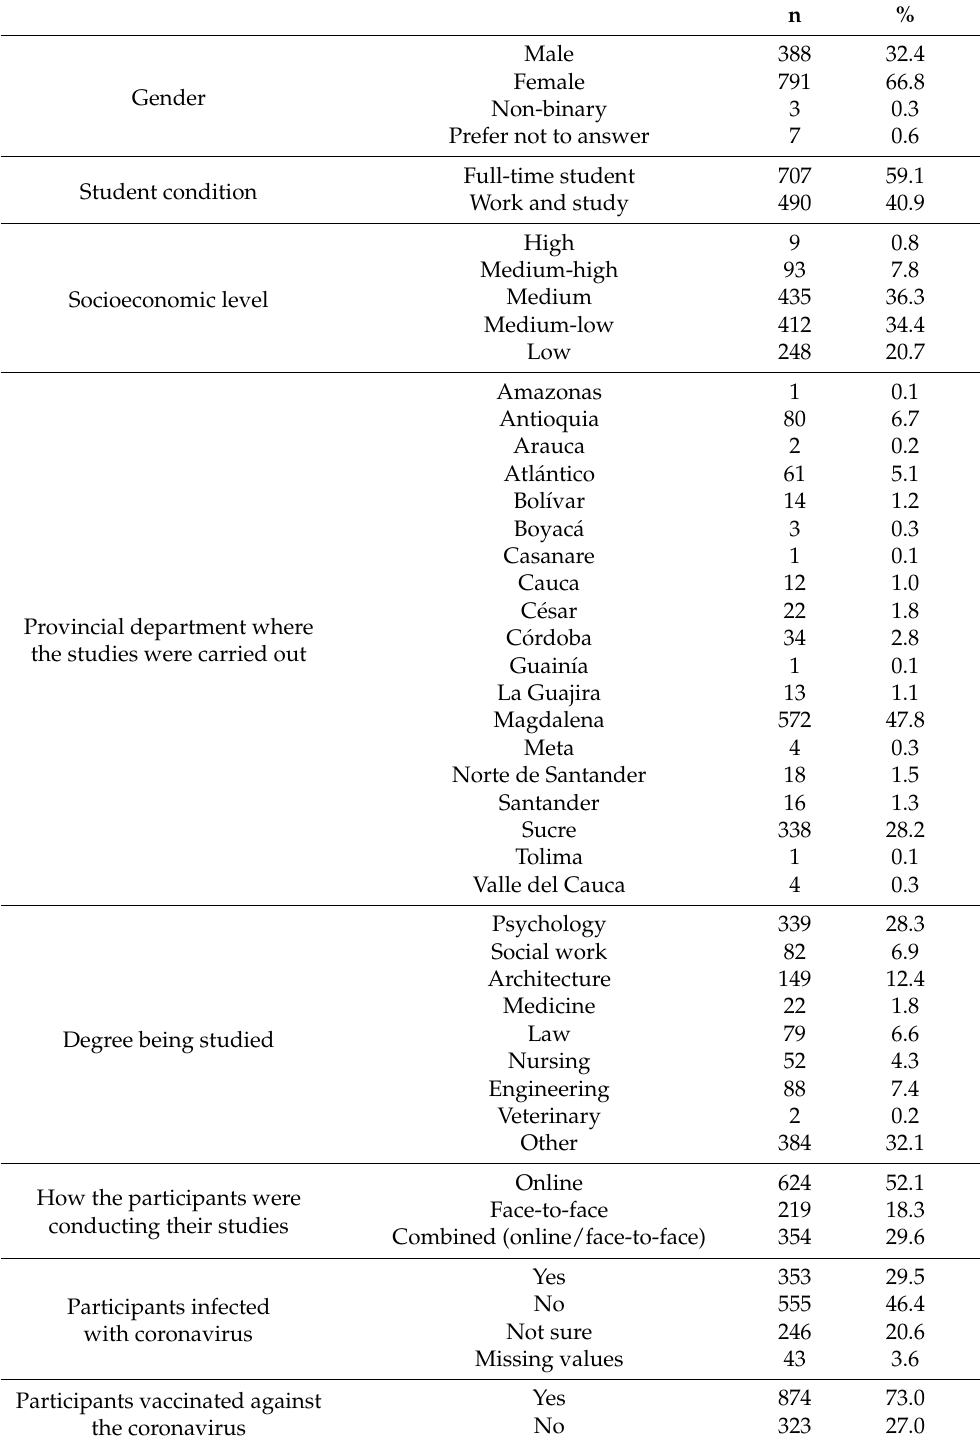
Table 1. Frequencies and percentages of sociodemographic variables (N =